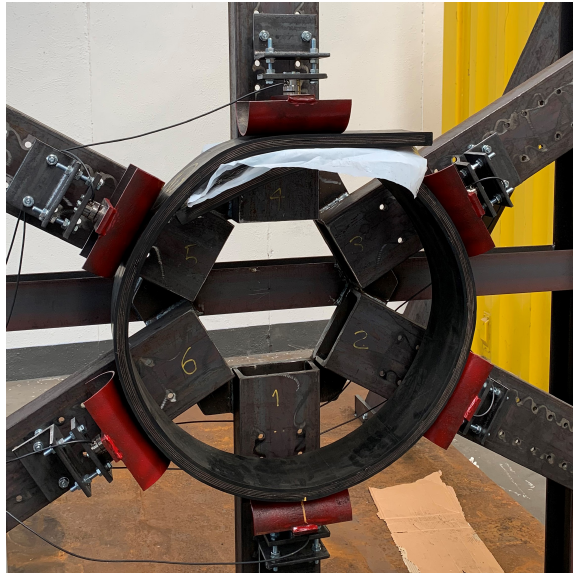
Figure 2: Six-point stiffness test device with sample installed in carrying strain configuration.